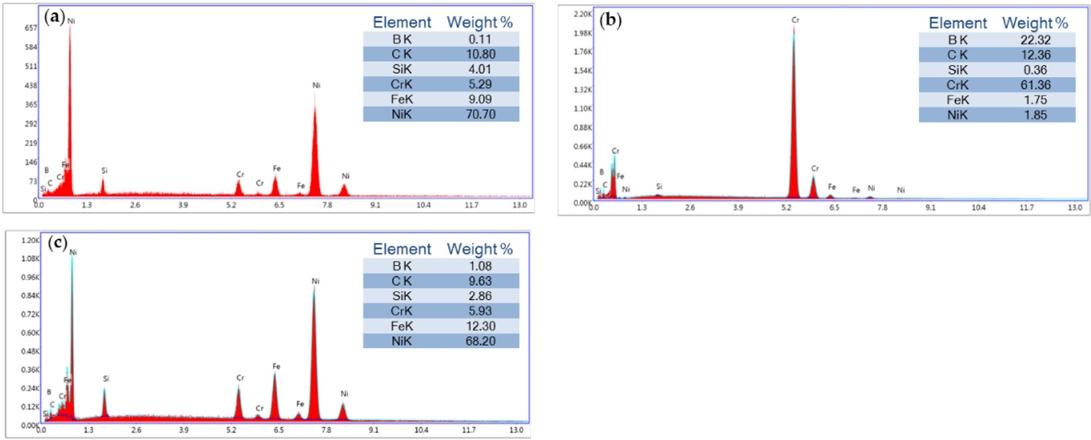
Figure 16. EDS analysis of three points. ( a ) A 1 ; ( b ) A 2 ; ( c ) A 3 .